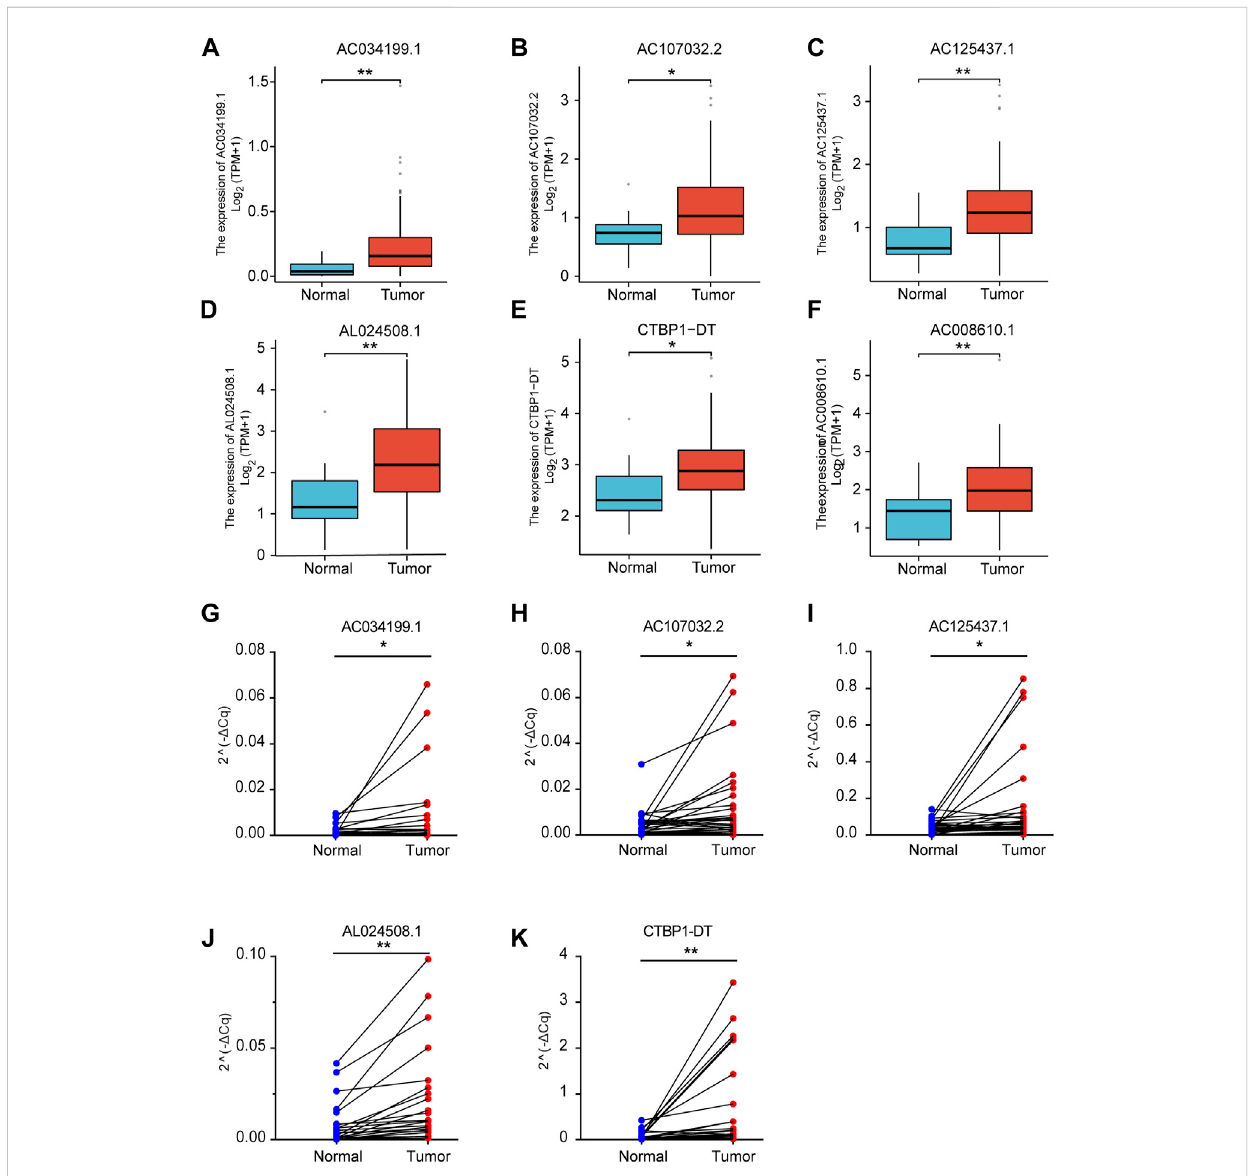
FIGURE 6 Expression of lncRNAs in TCGA and 40 paired ESCA tissues. The expression of AC034199.1 (A) , AC107032.2 (B) , AC125437.1 (C) , AL024508.1 (D) , CTBP1-DT (E) and AC008610.1 (F) in TCGA. qRT-PCR validation of expression of AC034199.1 (G) , AC107032.2 (H) , AC125437.1 (I) , AL024508.1 (J) , and CTBP1-DT (K) in 40 paired ESCA